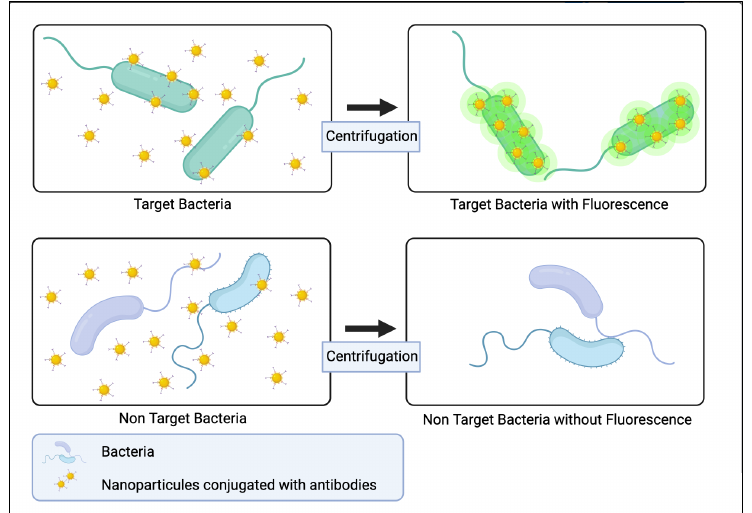
Figure 8. Drawing of bacterial cells with nanoparticles conjugated with antibody. The fluorescence intensity is strong, enabling single-bacterium cell identification in aqueous